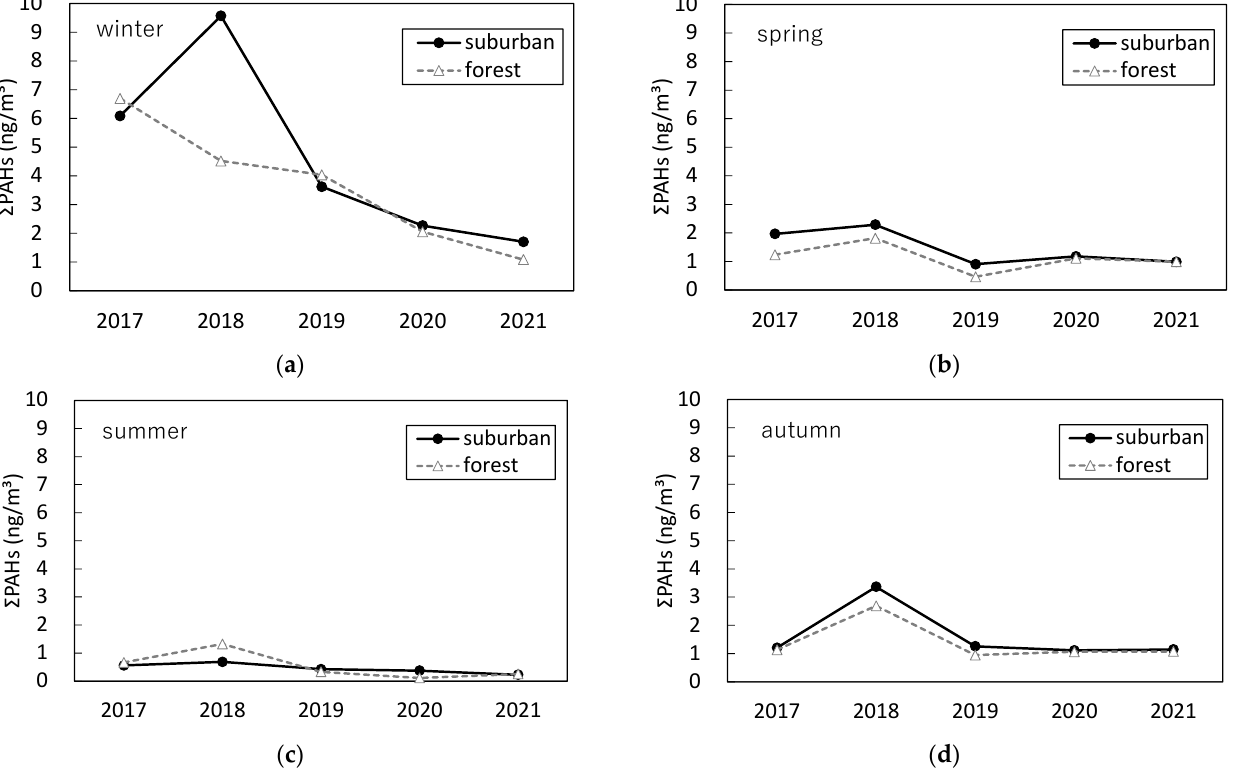
Figure 8. Behaviors in seasonal averages of total PAH concentrations in the suburban and forest sites of Nagasaki each year from 2017 to 2021: ( a ) winter; ( b ) spring; ( c ) summer; ( d ) autumn. In spring, PAHs decreased by 50% in suburban site and by 20% in forest site, but with a smaller range than that observed in winter. This may be due to more air mass advection in spring from directions other than northeastern China, and the reduced amount of coal and biomass burning for heating compared to that in winter. Similarly, the autumn PAH concentrations did not decrease significantly during this period.